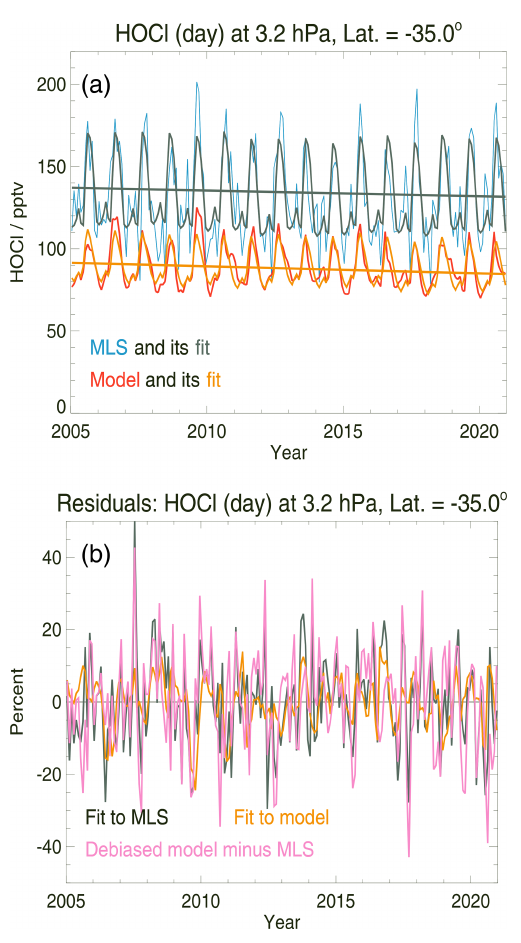
Figure 8. Same as Fig. 2 except for an example at 3.2hPa for 30 to 40 ◦ S (a) HOCl time series and regression fits and (b) percent residuals.